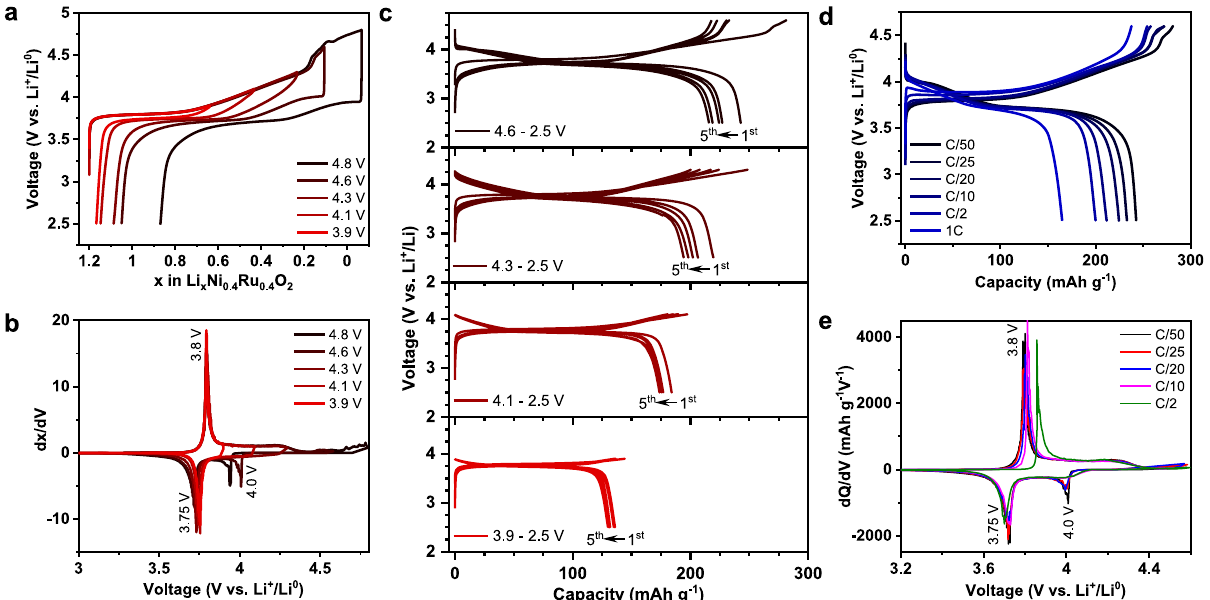
Fig. 2 Electrochemical characterization of Li 1.2 Ni 0.4 Ru 0.4 O 2 . a The fi rst cycle voltage pro fi les, b dx/dV plots, and c voltage pro fi les during the fi rst fi ve cycles at different charge cutoff voltages. d Voltage pro fi les and e dQ/dV plots at different rates. Cells are cycled at 5 mA g − 1 in a – c and between 4.6 and 2.5 V in d , e .